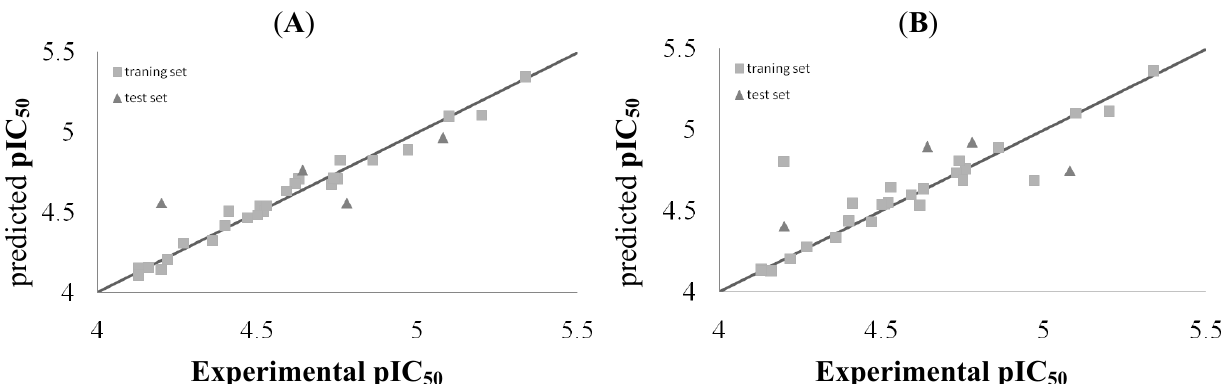
q 2 , Crossvalidated correlation coefficient using leave-one-out procedure; N , optimal number ofprincipal components; r 2 , non crossvalidated correlation coefficient; F : F-test value; Steric (S) and Electrostatic (E)